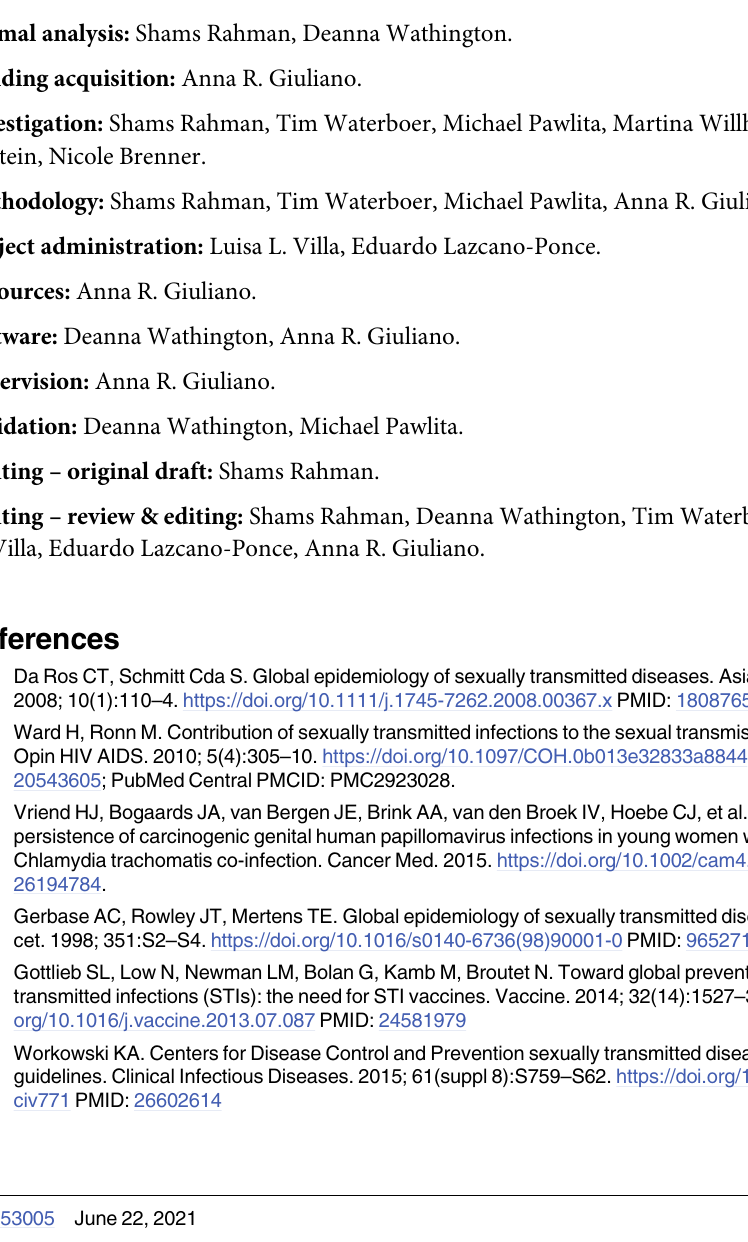
S1 Table. A comparison of the baseline characteristics for the simple random sample and the full parent HIM study